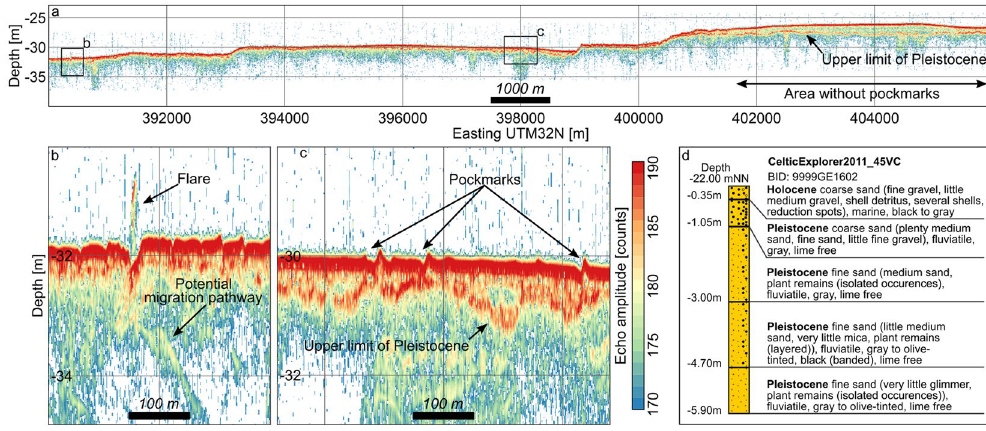
Figure 4. Geological setting of Helgoland Reef. ( a ) Sub-bottom profiler (SBP) transect across the pockmark field. ( b ) Detail of the methane flare. ( c ) Exemplary detail of pockmarks. ( d ) Description of core CE11_45VC 32 . See Fig. 1 for the location of the SBP transect and the